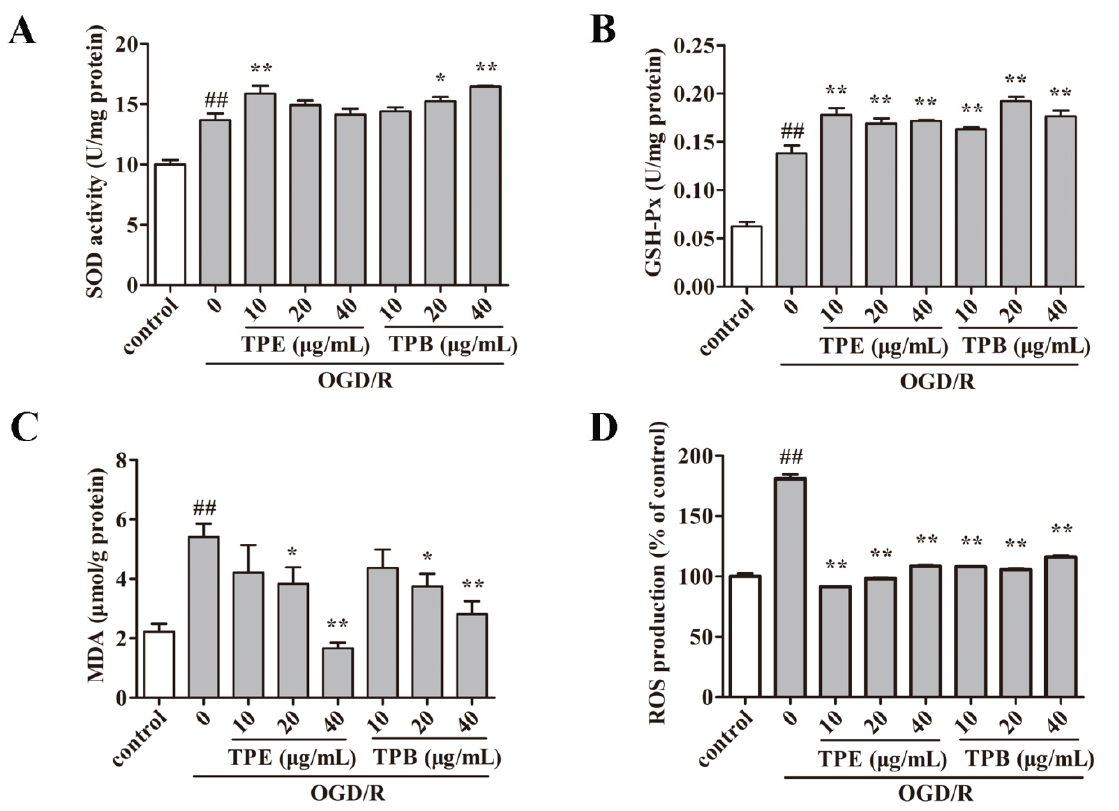
Figure 4. TPE and TPB effects on OGD/R injury was measured by quantifying SOD activity ( A ), MDA levels ( B ), GSH-Px levels ( C ) and ROS production ( D ). ## p < 0.01 vs. control group, * p < 0.05, ** p < 0.01 vs. OGD/R group.